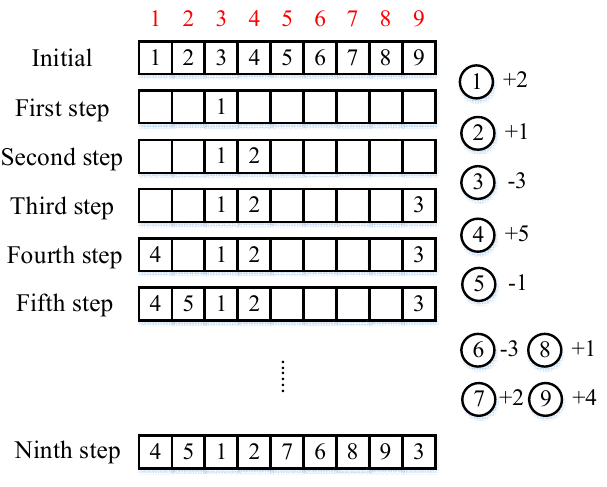
Figure 3. Task mapping move.